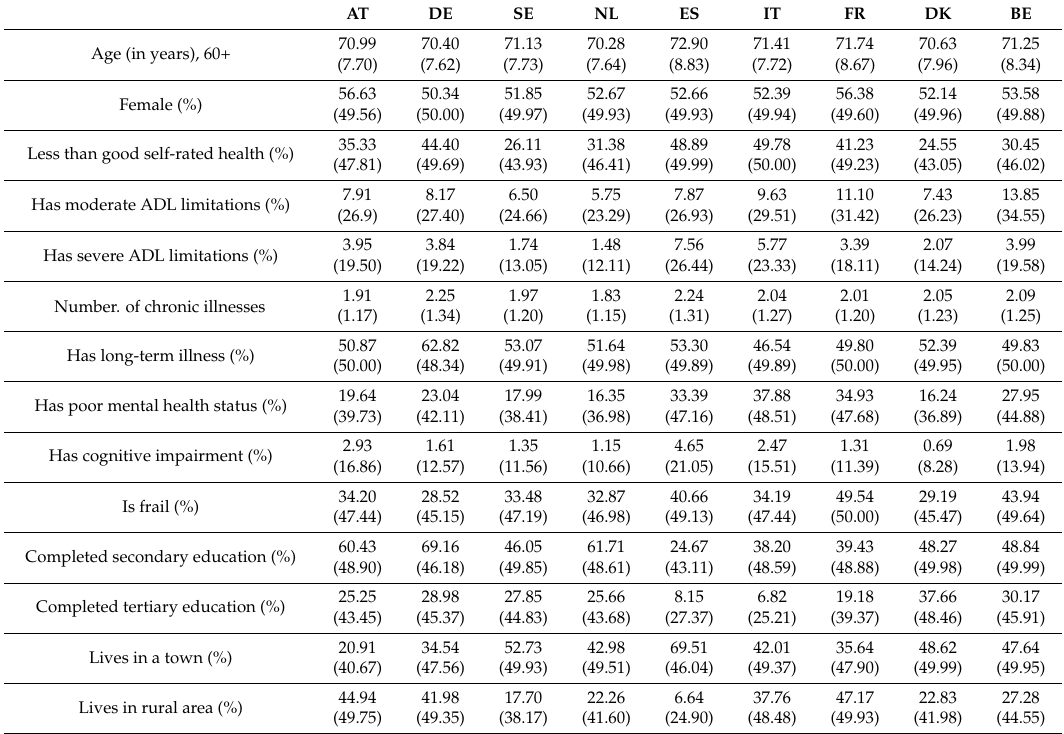
Table 1. Descriptive statistics for dependent and independent variables by country, percent/mean (standard